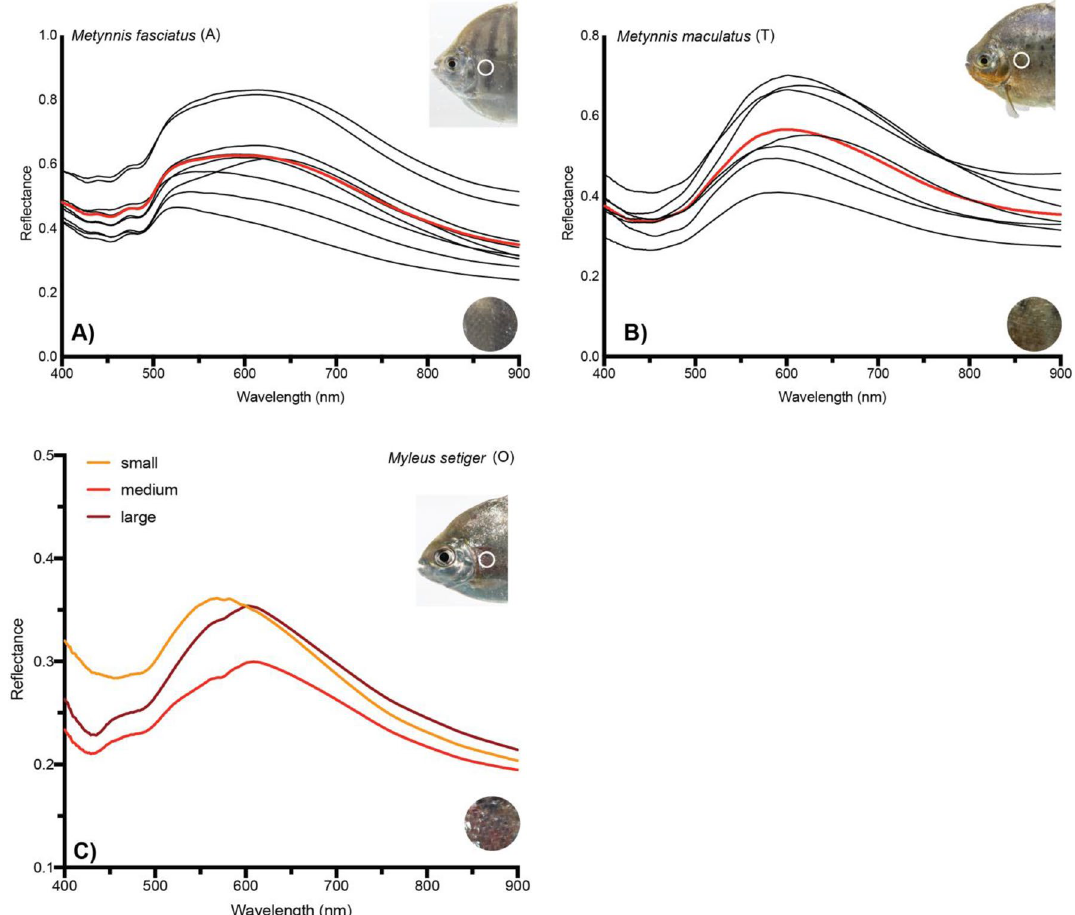
Figure 6. Intraspecific spectral signatures comparisons within select serrasalmid taxa. Variation within ( a ) Metynnis fasciatus and ( b ) Metynnis maculatus . Each line represents the spectral signature of an individual. Mean spectral signature is shown in red. ( c ) Ontogenetic change in spectral signature variation in Myleus setiger . Inset photograph shows a ‘medium’ individual. The shift in peak spectral signature towards red wavelengths can be seen from medium and large individuals. Circular close-up of the measurement area shows a red coloration of the scales. This is absent in small